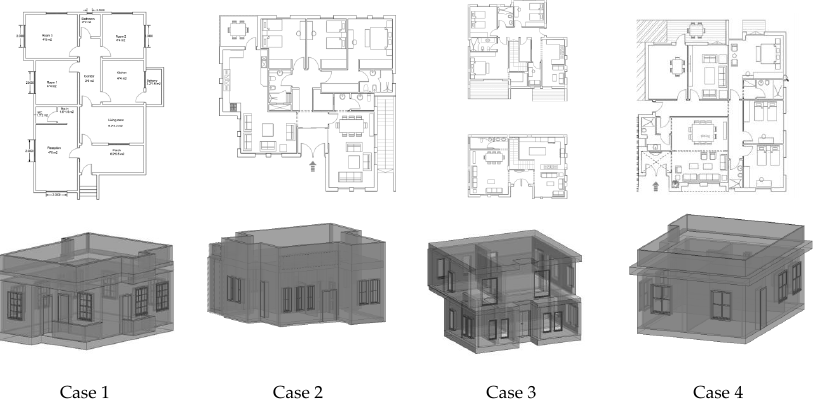
Figure 3. The modeled representative reference cases and architectural plans (1 – 4). Table 3. Input data used for creating the representative reference cases.